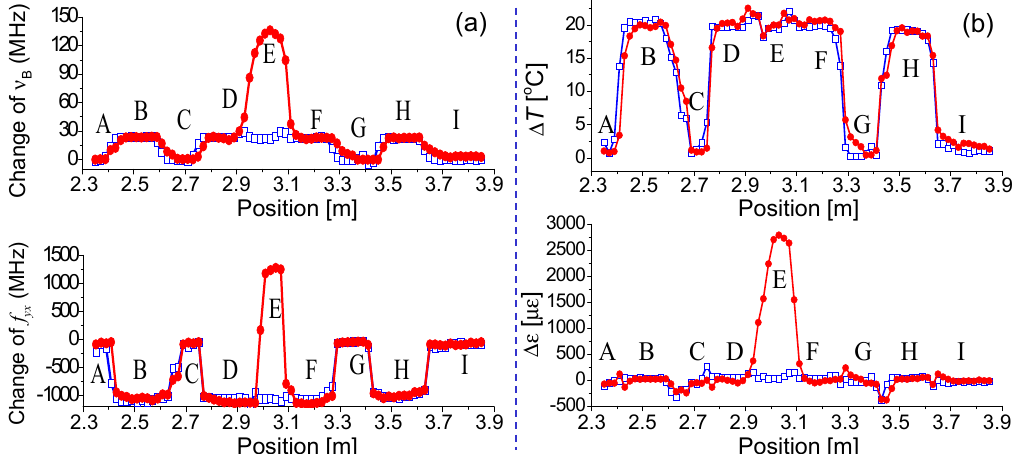
Figure 43. Experimental demonstration of distributed and discriminative measurement of strain and temperature [18]. ( a ) Measured distribution of BFS and birefringence-induced Bragg frequency difference. Blue data; B, D, E, F, and H sections are heated, but no strain is applied. Red data; temperature distribution is the same, but strain is applied at only the E section; ( b ) Strain and temperature distribution calculated by Equation (5).